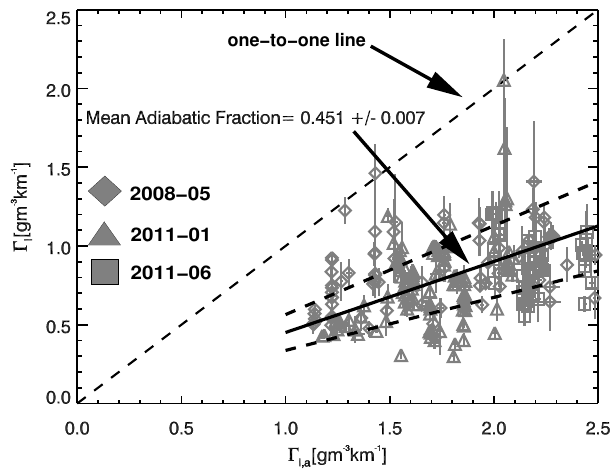
Figure 17. Adiabatic cloud-base liquid water lapse-rate values ( (cid:48) l,a ) and the corresponding lidar-derived values ( (cid:48) l ). The thin- dashed line represents the one-to-one line (adiabatic fraction = 1), while the thicker solid and dashed lines show the observed rela- tionship based on the chi-square mean observed fraction and corre- sponding